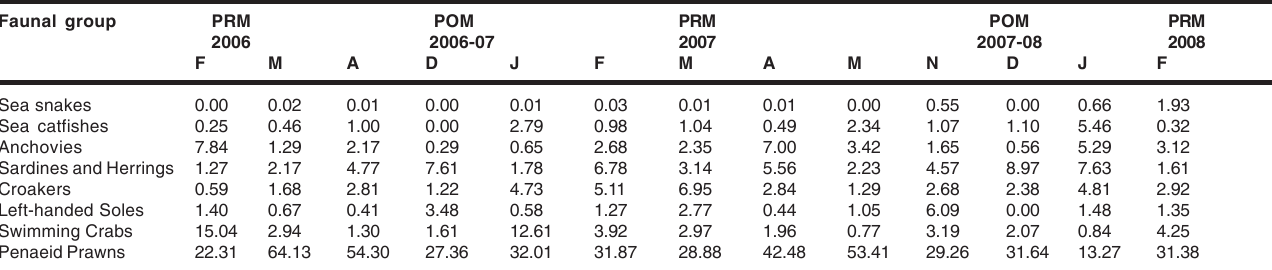
Table 3. Month wise percentage of sea snakes and their dietary items in the trawl catches of Goan coast Faunal group